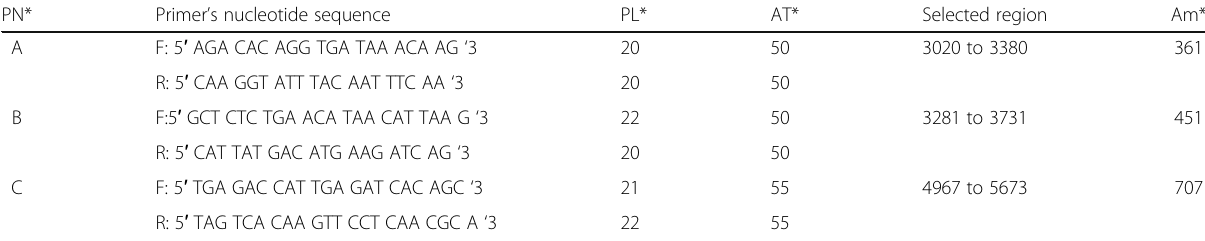
Table 1 List of primers used to amplify BRCA2 gene selected regions PN* Primer ’ s nucleotide